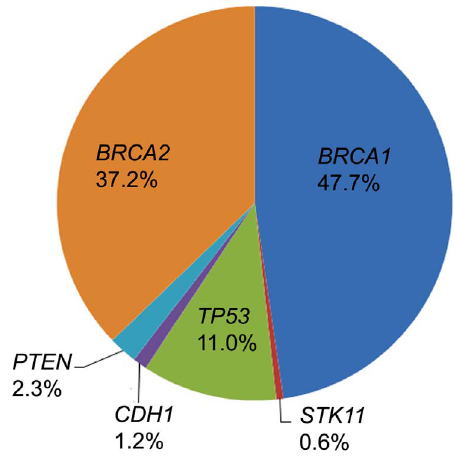
Figure 7. Distribution of pathogenic mutations reported out in first 3,000 patient samples referred for BRCAplus testing.